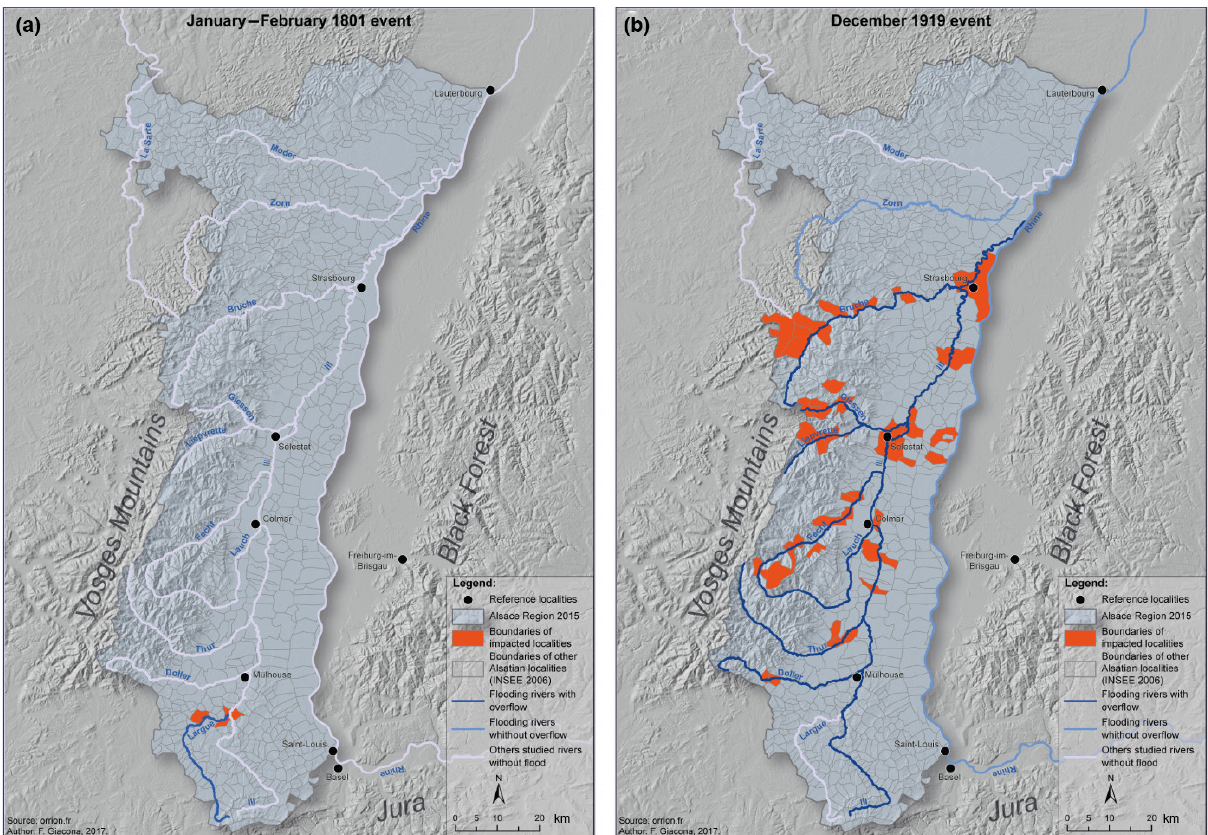
Figure 5. Maps of specific class III–IV events. (a) January–February 1801 event. T configuration (Alsatian tributaries of the Rhine River alone). Extent score: 0. Damage score: 2. Class III event. Overflowed Largue River caused environmental damage and impacted five mu- nicipalities. This flood is attributed to snow melting/thaw and to heavy rainfall. It is known from one source. (b) December 1919 event. RT configuration (Rhine River and its Alsatian tributaries). Extent score: 2. Damage score: 2. Class IV event. Overflowed Ill, Doller, Thur, Lauch, Fecht, Lièpvrette, Giessen, and Bruche rivers caused human, environmental, functional, and material damage and impacted 45 mu- nicipalities. Rhine and Zorn rivers were flooded without overflow. This event is attributed to snow melting/thaw and heavy rainfall and is known from 61 sources. Table 1. Characteristics of the 13 considered rivers in terms of length and 10- and 50-year return period peak discharge according to local flood prevention plans. River (municipality in which